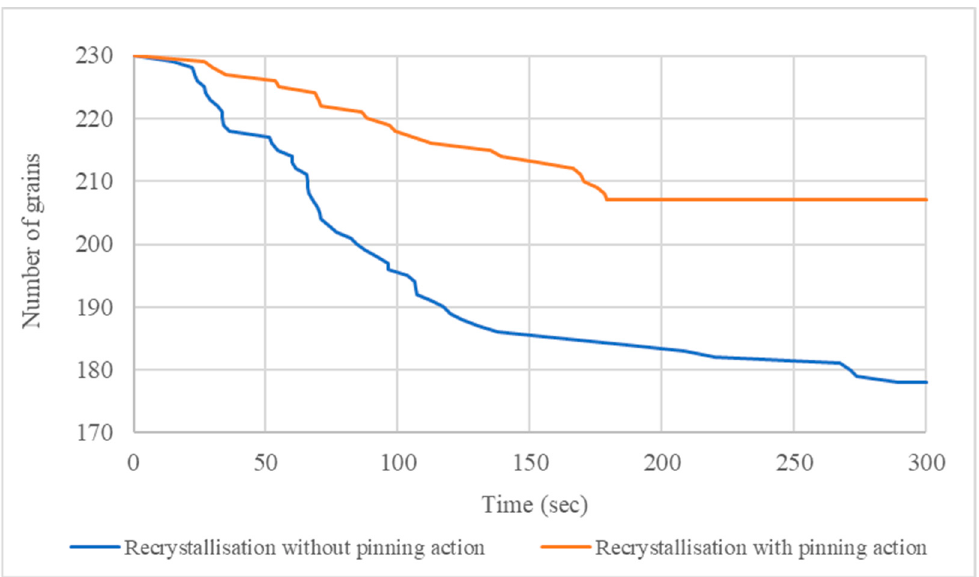
Figure 4. Evolution of the recrystallized grains average radius.